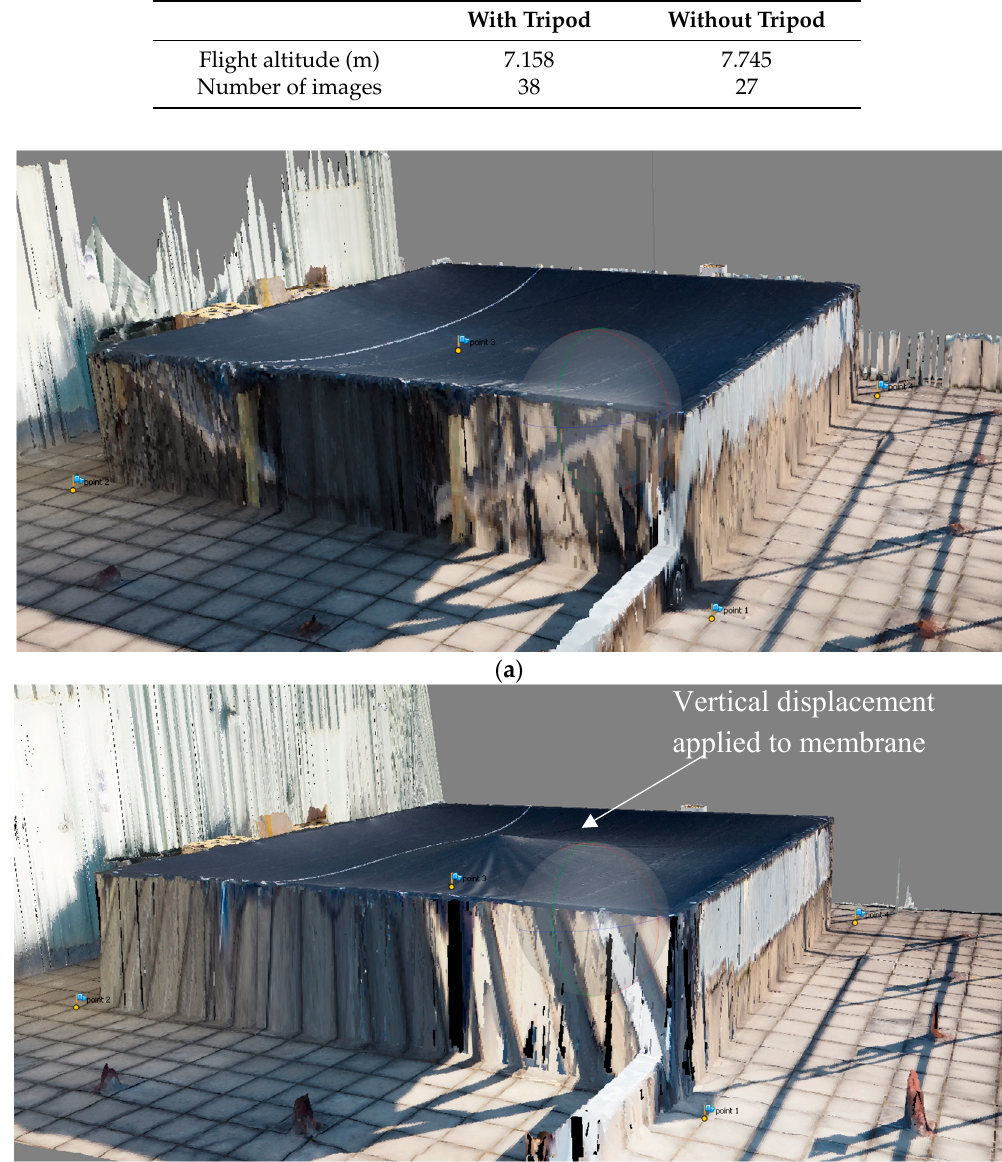
Figure 26. ( a ) 3D reconstruction of the rooftop membrane with edge supports (“initial” state); and ( b ) 3D reconstruction with the application of a vertical displacement in the middle of the membrane (“deformed” state).